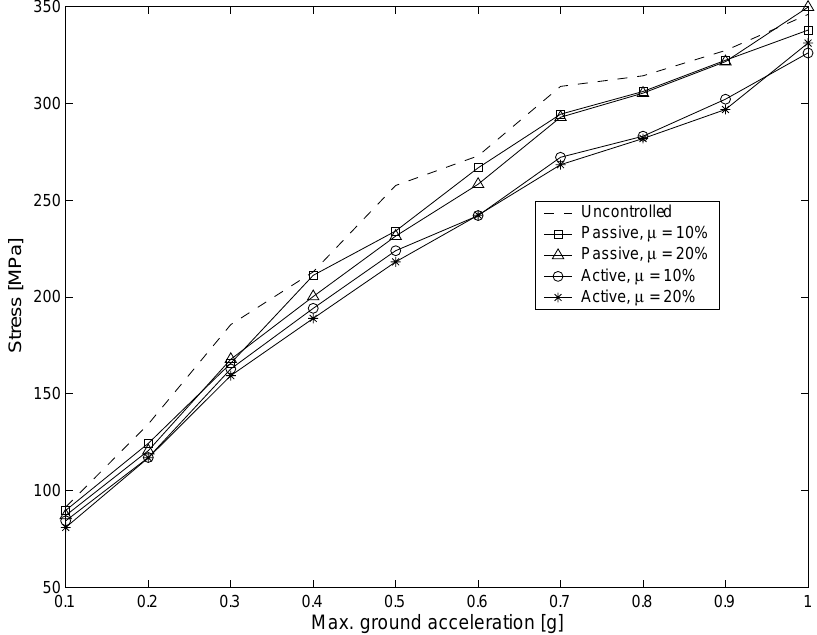
Fig. 4. Mean-plus-one-standard-deviation of the maximum stress in the rail with passive and active devices for an ensemble of synthetic ground motions. orders of magnitude on the higher end. (The small probability values shown in these figures should not be taken to represent the true system reliabilities as they are functions of the assumed distributions. Rather, they should only be viewed as some measures of the relative effectiveness of the protective system in reducing the fragility.) In general, the active control is seen to improve the performance of the elevator system, and the 20% ratio mass damper seems perform better than the smaller mass ratio